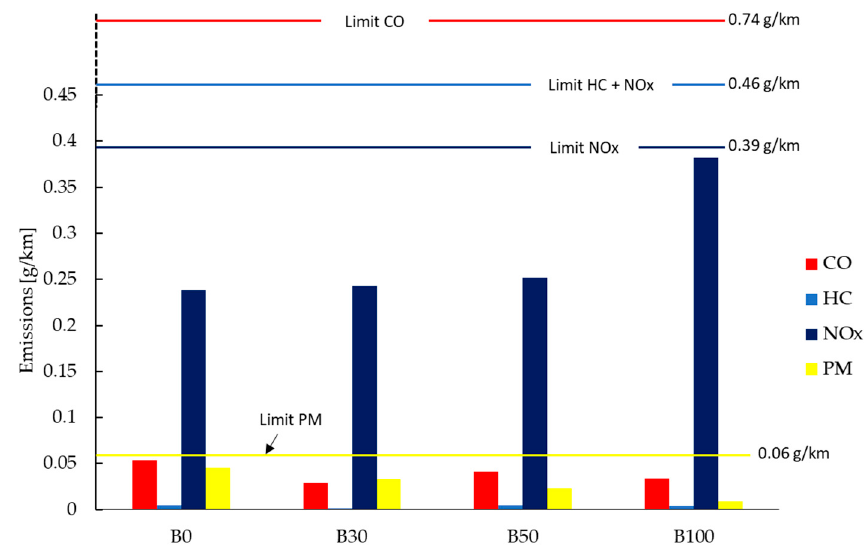
Figure 5. Diesel fuel and biodiesel vs limits imposed by the Euro4 standard.